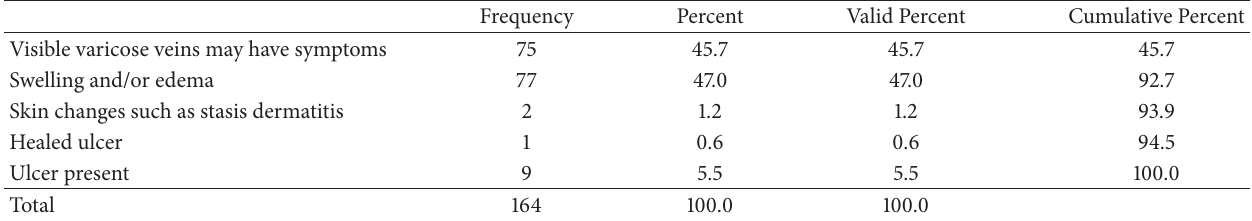
Table 4: CEAP class at 2010